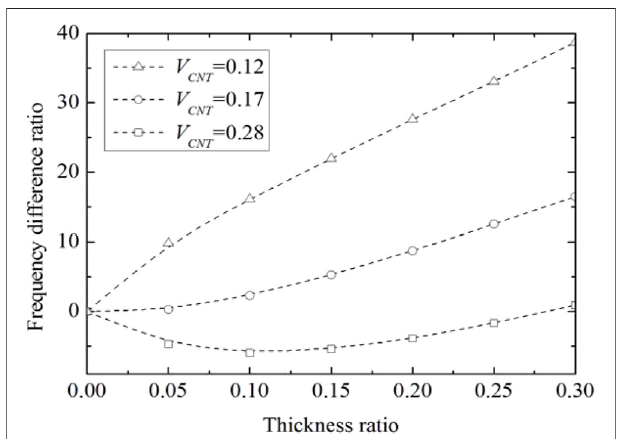
FIGURE 5 | Variation of frequency difference ratio with the thickness ratio under SSSS boundary conditions.